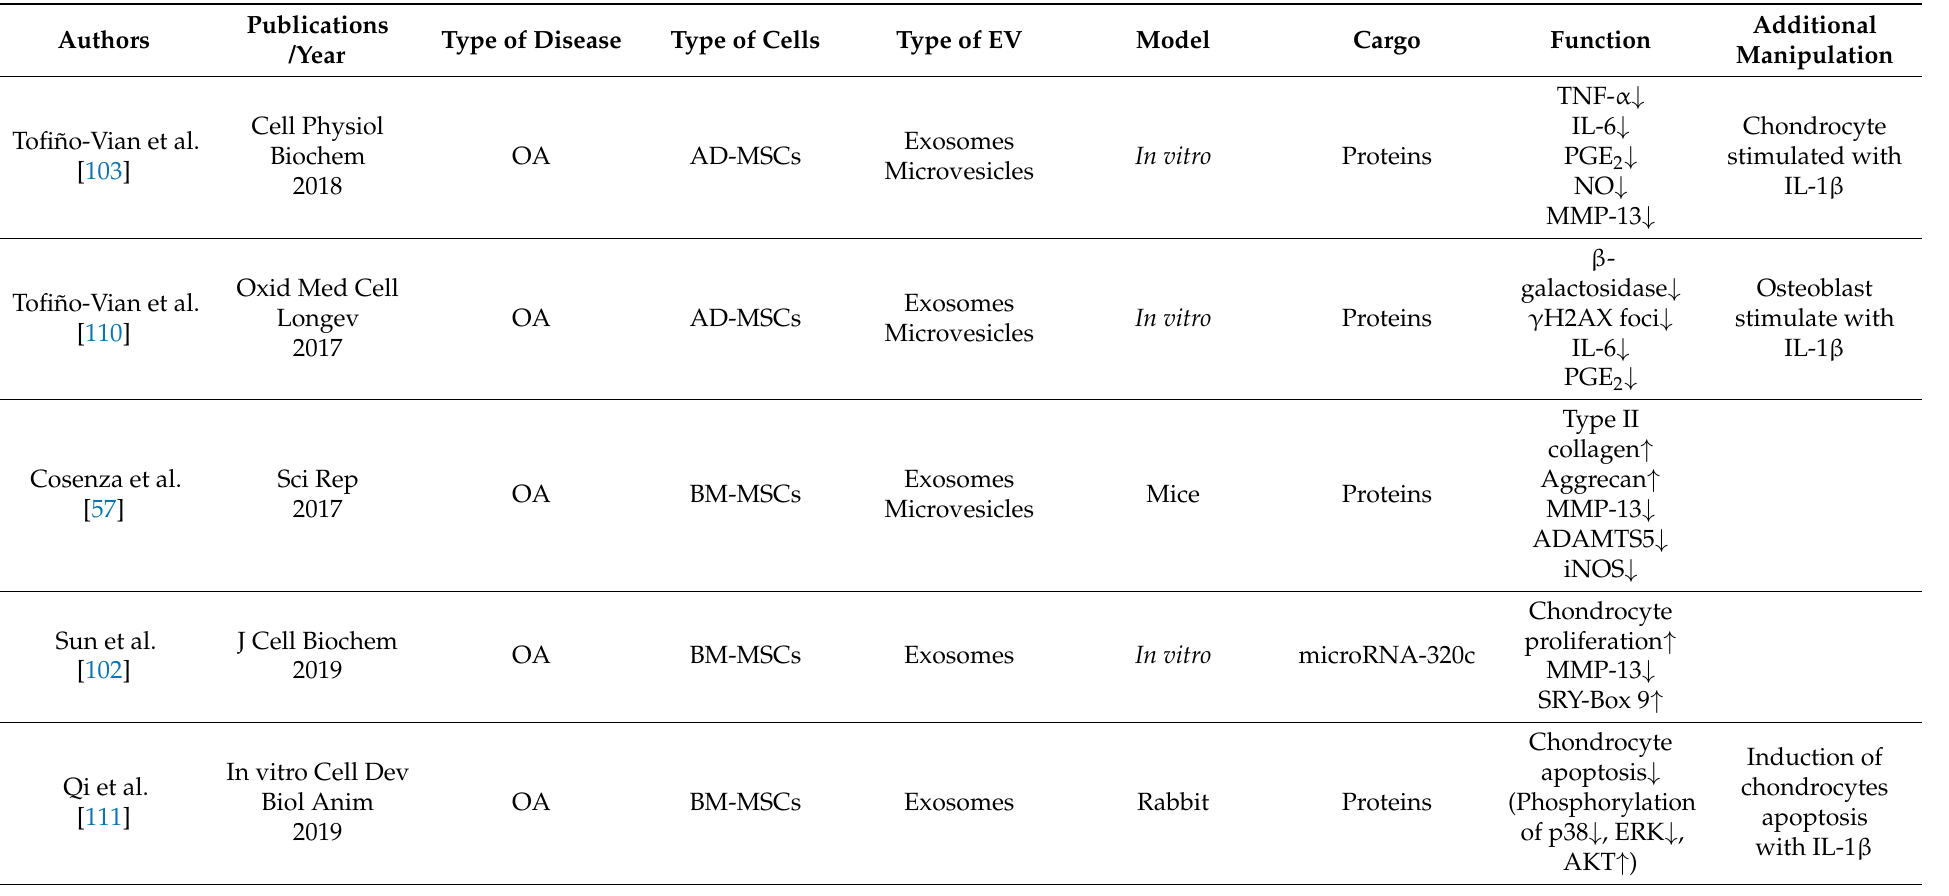
Table 2. Details of studies on MSC-derived extracellular vesicles in